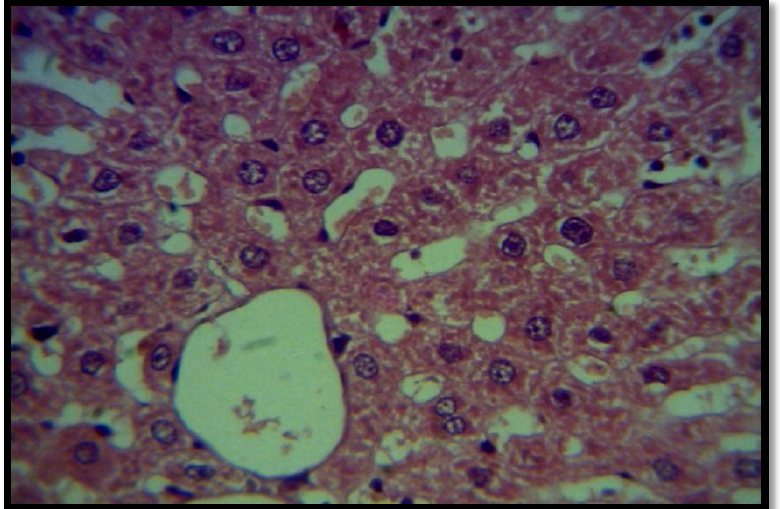
Figure (1):- Histological section in the liver of control group shows normal liver parenchyma (H and E, X 40).